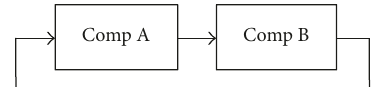
Figure 7: Communication between two